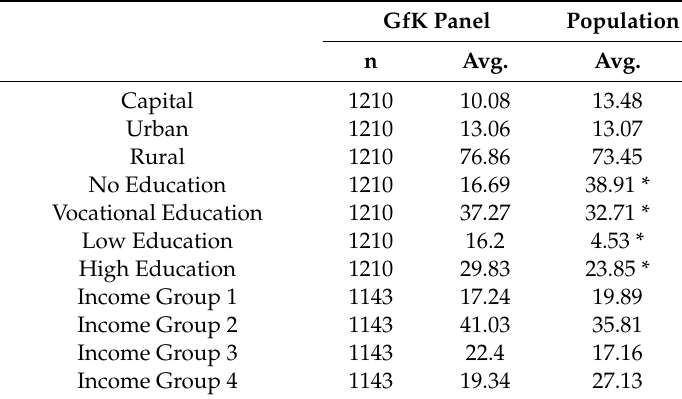
Table A11. GfK versus general population in